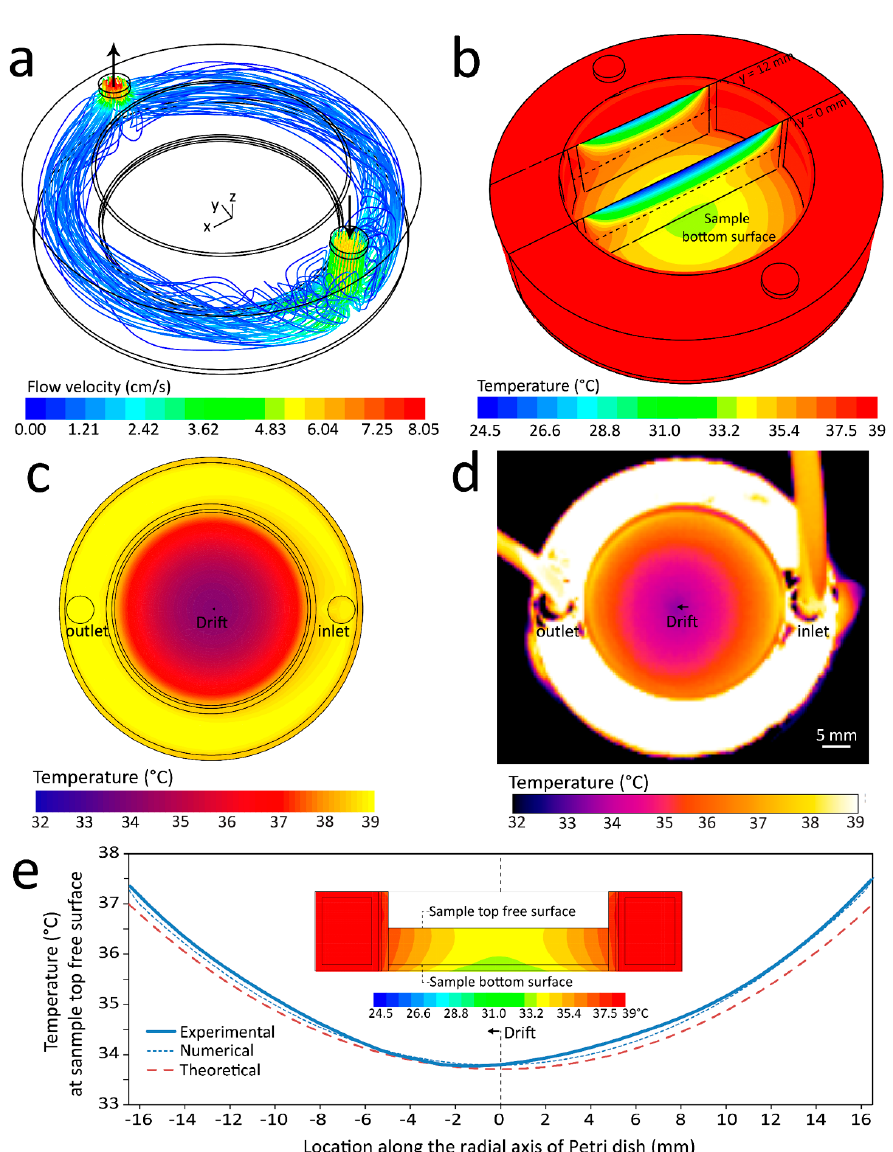
Figure 2. Analyzing the thermal performance of the water jacket system under steady state reference conditions. ( a ) Flow streamlines along the water jacket chamber are colored by the magnitude of the velocity. ( b ) Temperature contours across different surfaces of the system. ( c ) Temperature contour at the top free surface of the water jacket system obtained by numerical simulations. ( d ) Temperature contour at the top free surface of the water jacket system obtained by thermal imaging camera. ( e ) Variations in temperature along the radial axis of the Petri dish at its top free surface obtained by experimental, numerical and theoretical analyses. Inset shows the temperature contours at the middle cross section of the Petri dish.